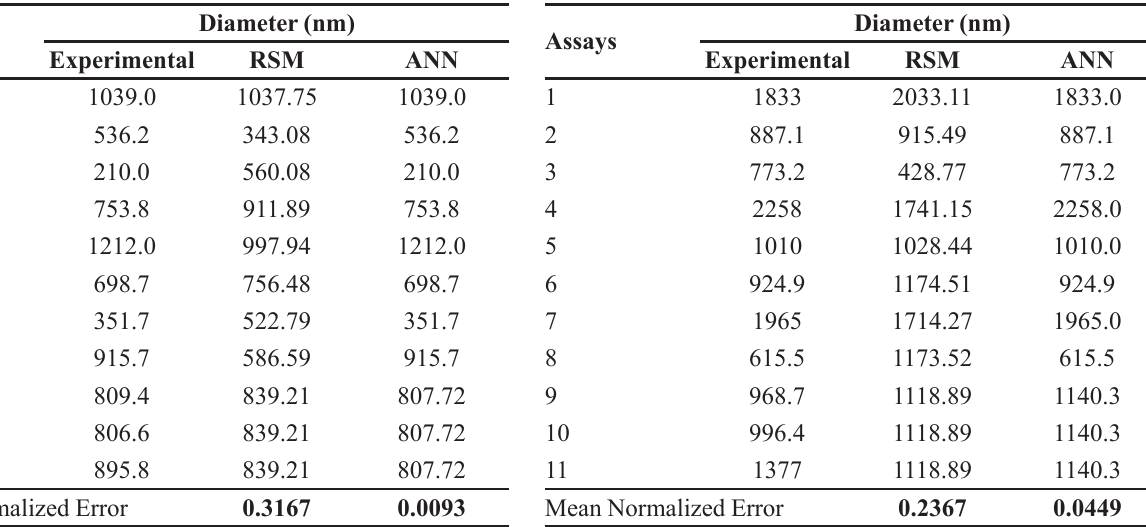
TABLE VI - Comparison between experimental data and predictive models generated by RSM and ANN. Data associated